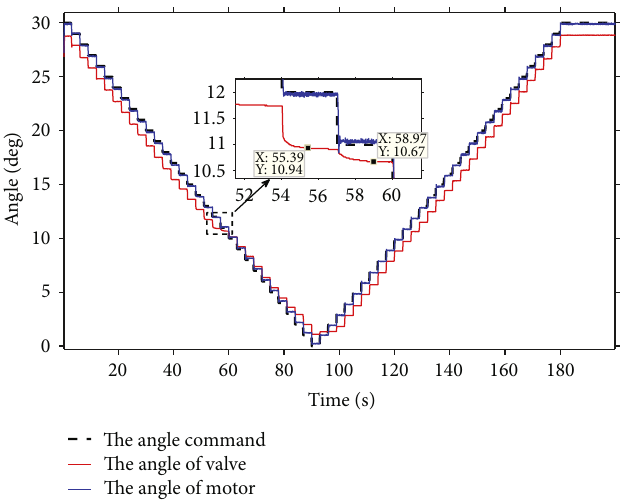
Figure 6: Valve angle response under large clearance